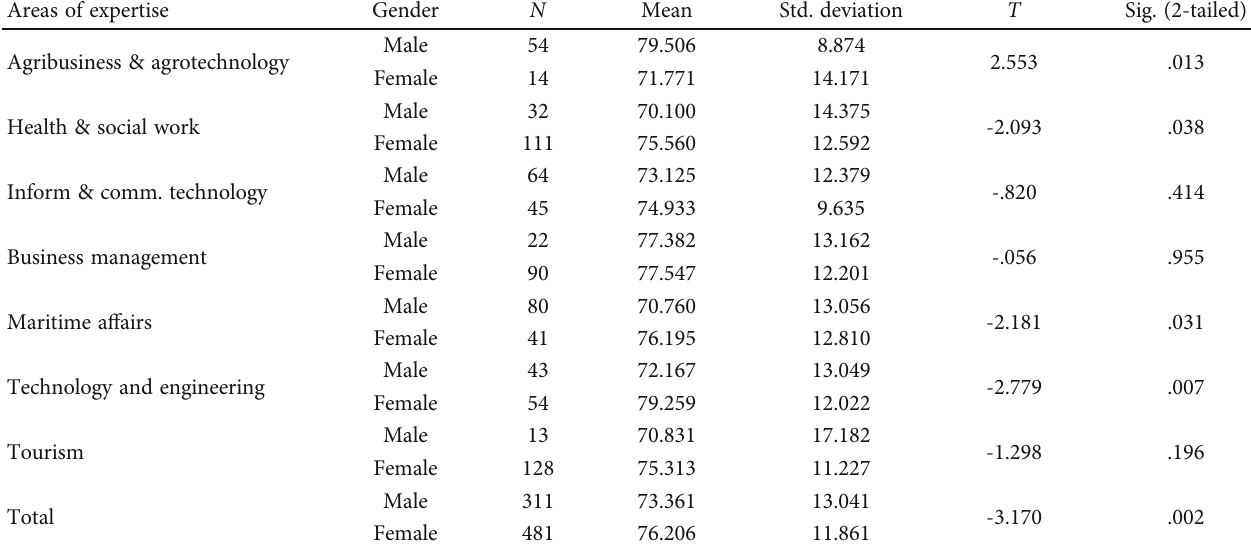
Figure 2: Comparison of the ESE scores between male and female students in 7 areas of expertise at vocational high schools. Table 2: The results of the independent sample T -test on ESE scores between male and female students. Areas of expertise Gender Mean Std. deviation Sig.